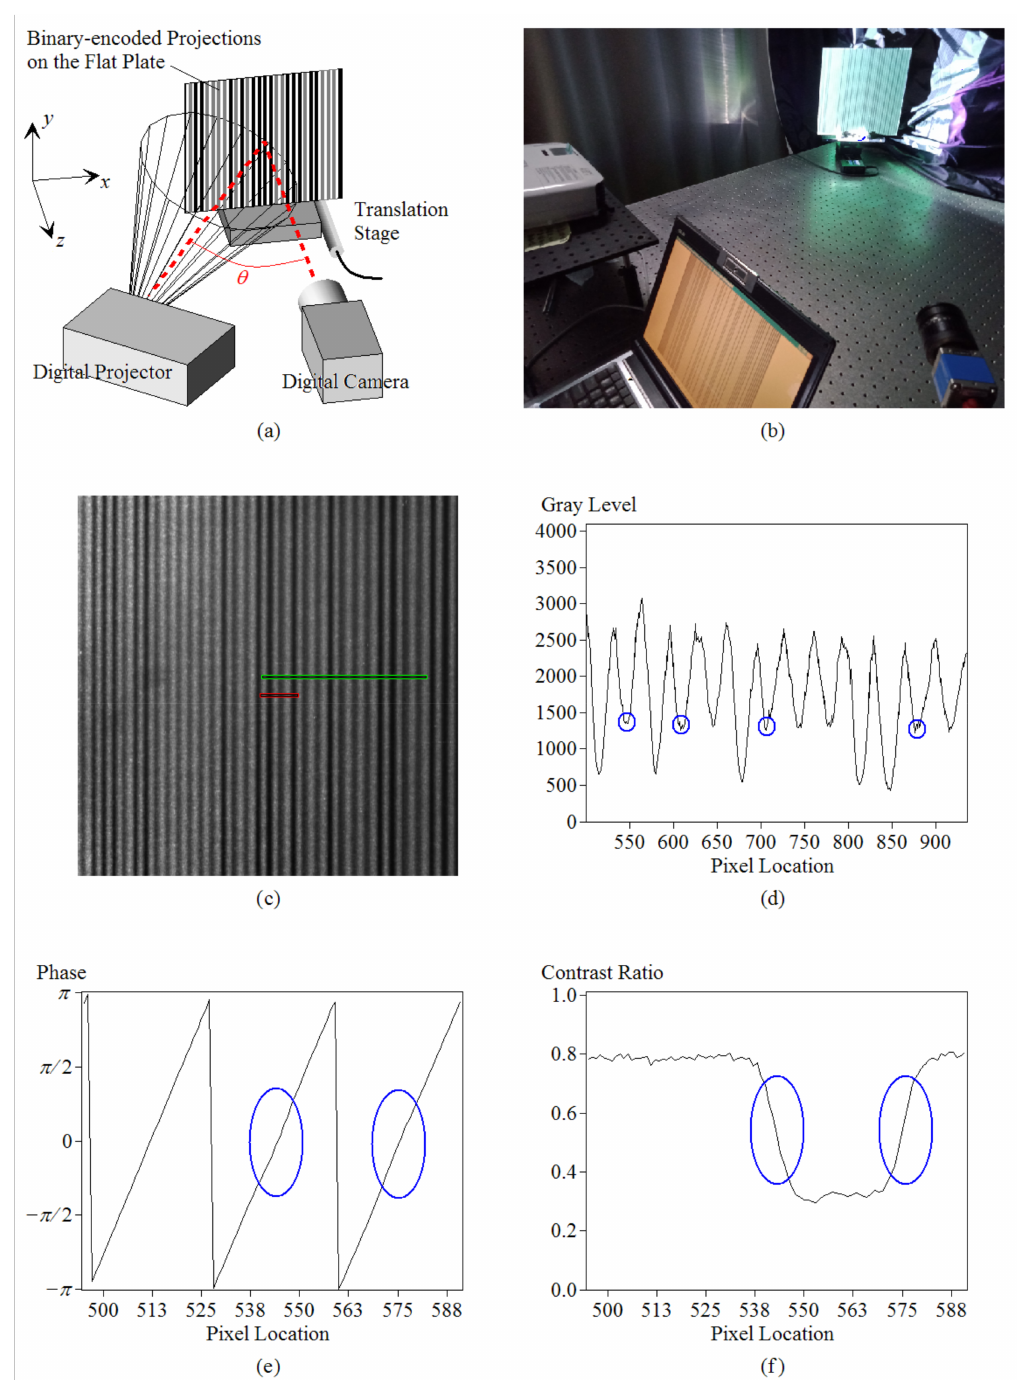
Figure 6. ( a ) An optical configuration for the phase-to-depth calibration. ( b ) A photo illustrating the experimental setup ( c ) An image recorded by the CCD camera for the 4th pattern projection on the flat plate. ( d ) A 1D gray-level distribution for the image row marked with a green frame. ( e ) Extracted phase distribution for the sampled image row marked with a red frame. ( f ) Extracted contrast distribution for the same image row in ( e